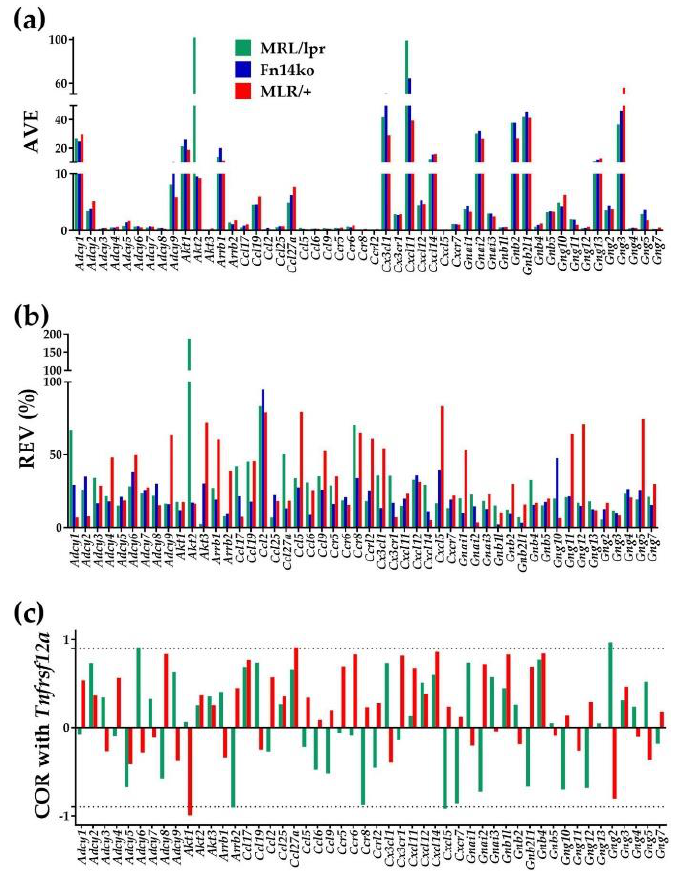
Figure 1. Three independent characteristics of 50 representative genes involved in chemokine signaling ( a ) Average Expression levels (AVE) as multiples of the median average expression levels of all quantified genes. ( b ) Relative Expression Variability (REV). ( c ) Expression correlation (COR) of each gene with Tnfrsf12a (Fn14) . Dotted lines indicate the interval outside which the correlations are statistically significant. Notes: (1) AVE is the pool estimate of the expression level of all spots probing the same transcript. (2) REV is the mid-interval chi-square estimate of the coefficient of variation accounting for the non-uniform number of spots redundantly probing the same transcript. (3) Pearson correlation coefficient and its statistical significance were determined for each redundantly probed gene pair in each phenotype by the Python 3 software presented in Reference